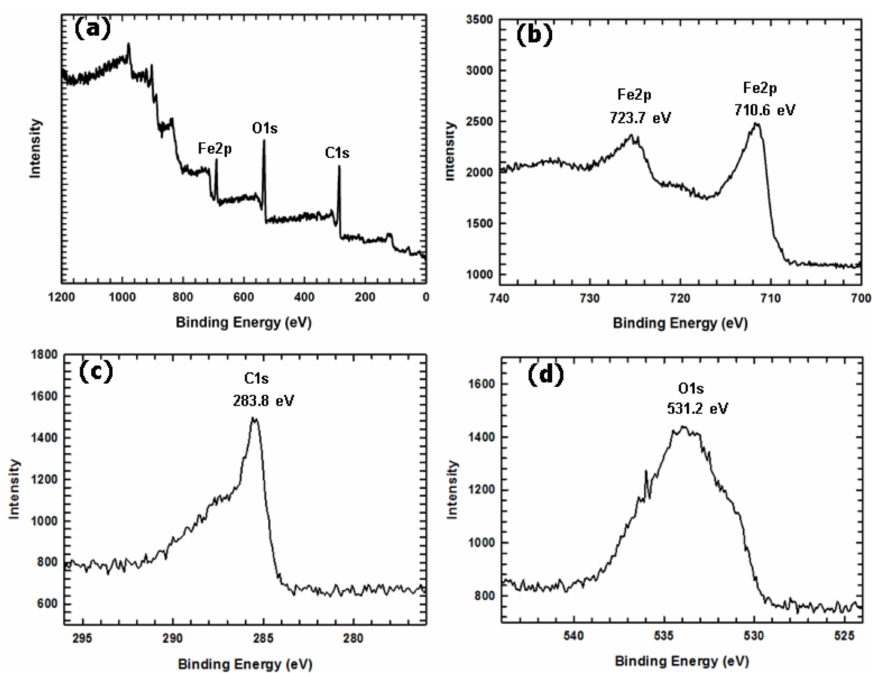
Figure 3. ( a ) Wide-scan X-ray photoelectron spectroscopy (XPS) spectrum and ( b – d ) Fe2p, C1S, and O1s core-level XPS spectra of Fe 3 O 4